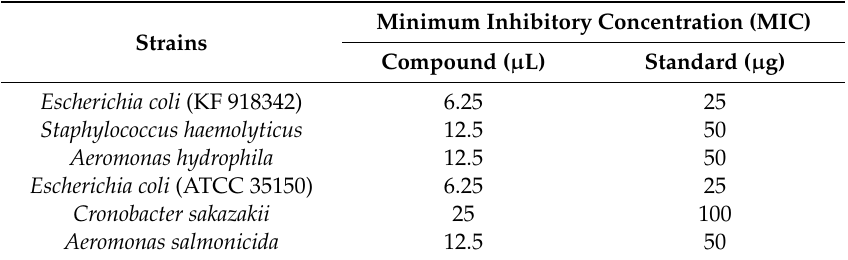
Table 4. Antibacterial activity of di ff erent organs of Lavandula pubescens .